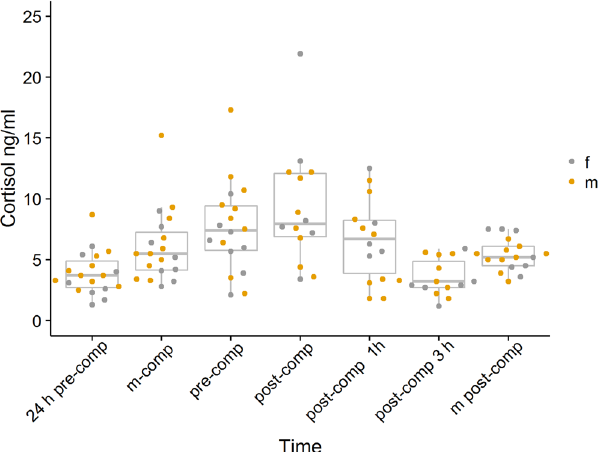
Figure 2. Time course of salivary C levels. 24 h pre-comp = 24 h before the Call Room. M-comp = morning of competition; pre-comp = before entering the Call Room; Post-comp = immediately after competition; post-comp 1 h = 1 h after competition; post-comp 3 h = 3 h after competition; m post-comp = morning after competition. Dots represent individual values, colour indicates